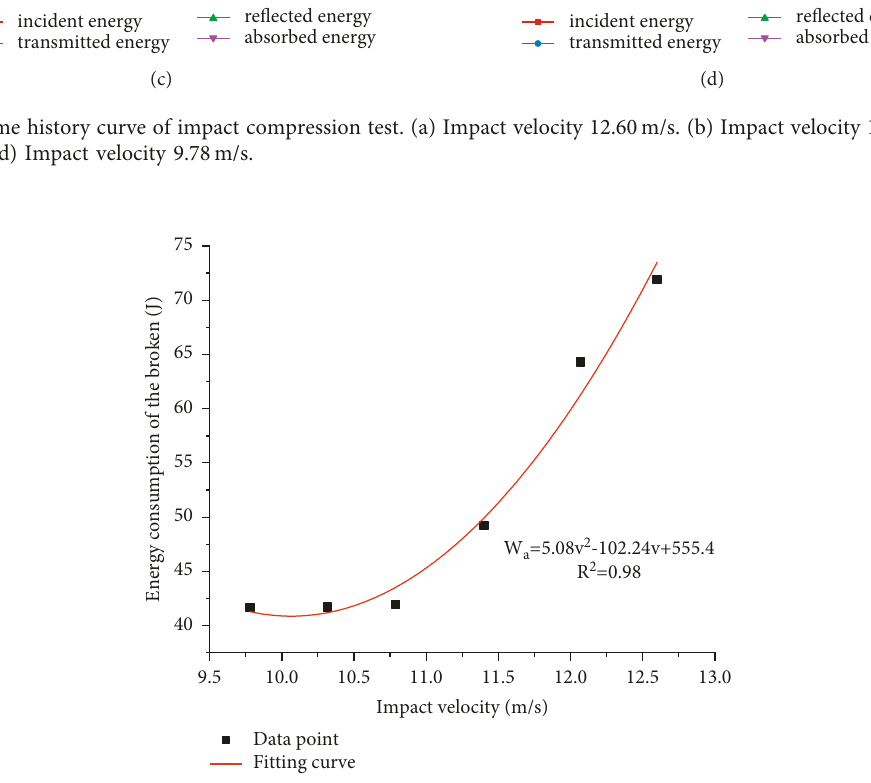
Figure 9: Fitting curve of crushing energy consumption-impact velocity in impact compression